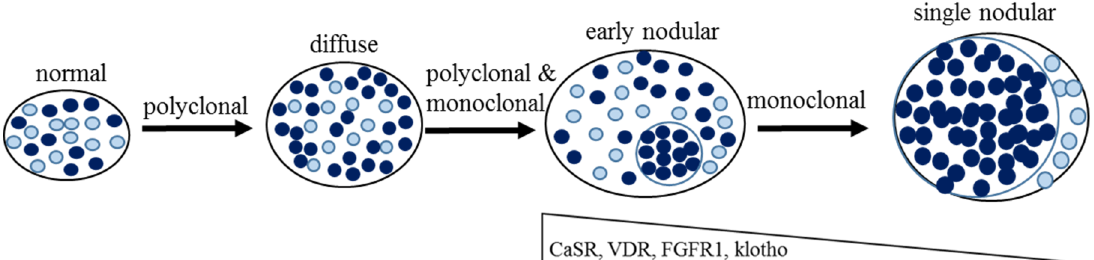
Figure 2. Parathyroid hyperplasia in chronic kidney disease (CKD) patients with SHP. Schematic presentation of the different stages of SHP: In the monoclonal state, the parathyroid cells become gradually autonomous and transform into a nodular pattern. At the level of nodular hyperplasia, there is reduced expression of the vitamin D receptor (VDR), calcium-sensing receptor (CaSR), and the fibroblast growth factor 23 (FGF23) receptor complex (FGFR1-klotho) and the parathyroids become refractory to conventional medical therapy. Light and dark blue circles correspond to polyclonal growth within a parathyroid tissue, which develops into monoclonal (dark blue) benign cell proliferation in severe SHP.